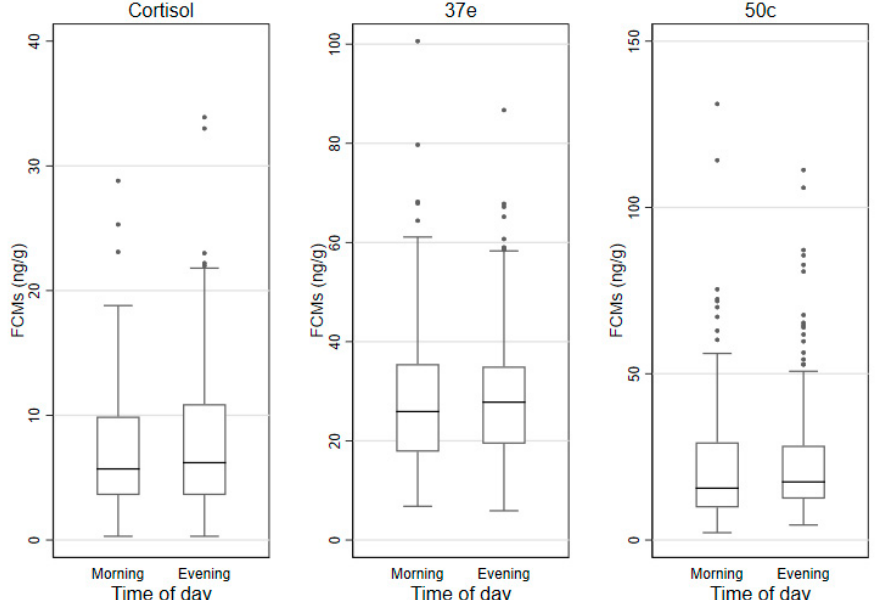
Figure 4. Box and whisker plots for FCM (faecal cortisol metabolite) levels (ng/g) measured with the cortisol, 37e (5 α - pregnane-3 β ,11 β ,21-triol-20-one) and 50c (tetrahydrocorticosterone) EIAs (enzyme immunoassays) in morning and evening samples (defecations: n = 182 and n = 169 respectively).